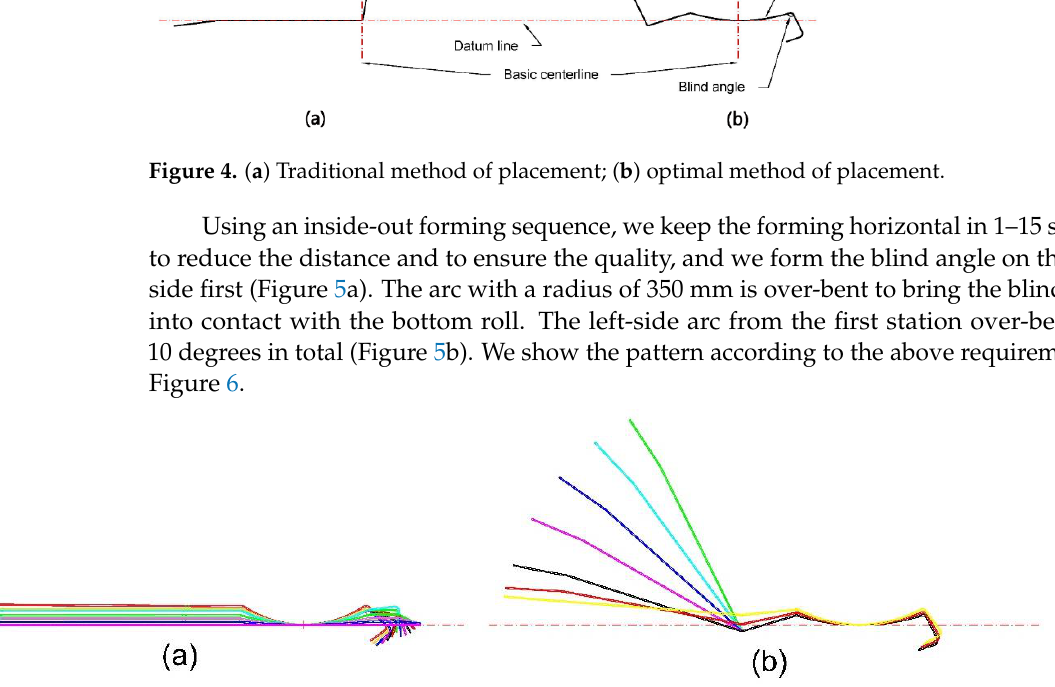
Figure 5. Flower pattern of ( a ) horizontal forming of 1 – 15 stations; ( b ) depth increasing in forming of 16 – 24 stations.